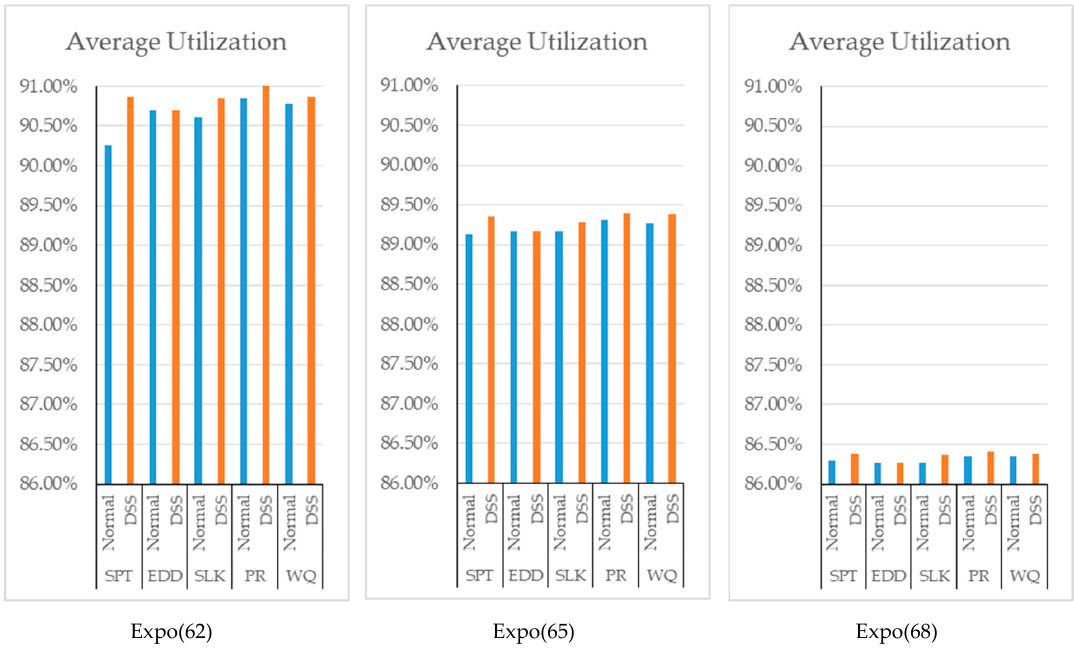
Figure 5. Average utilization.